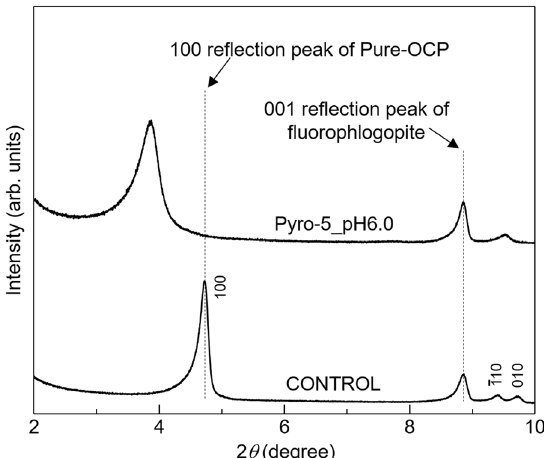
Fig. 4 XRD analysis. Powder XRD patterns of plain OCP (CONTROL) and OCP with incorporated pyromellitate ions (Pyro5_pH6.0). Fluorophlogopite powder was added to these samples as an angular standard material.